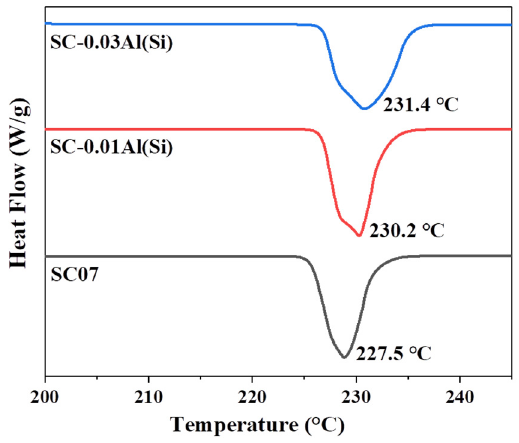
Figure 6. DSC results for the SC07, SC-0.01Al(Si), and SC-0.03Al(Si) solders.